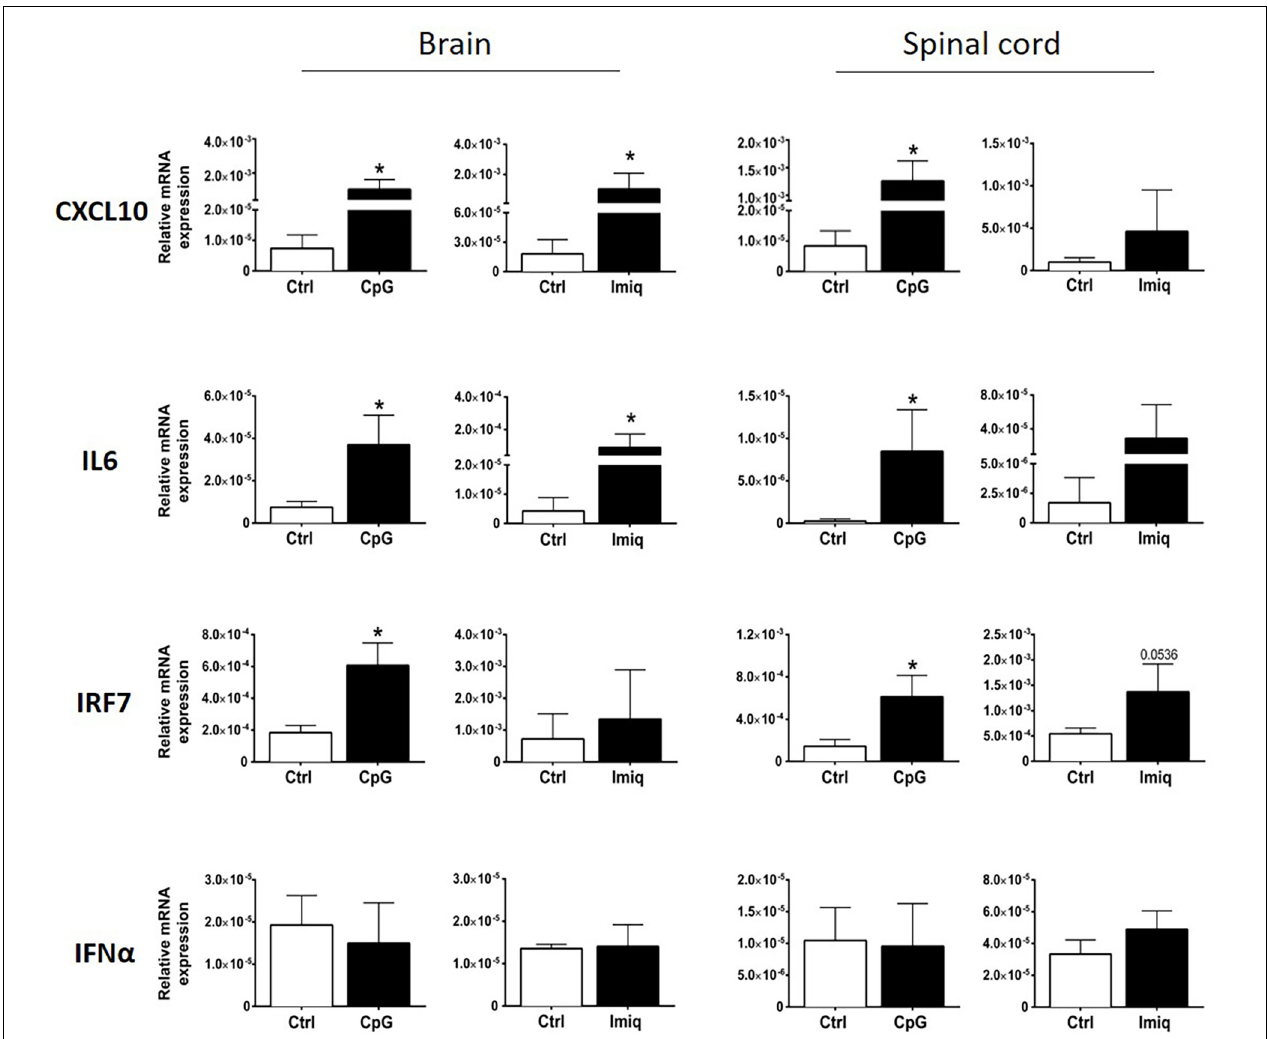
FIGURE 1 | Intrathecal CpG and Imiquimod induced overlapping but distinct immune response in the central nervous system (CNS). mRNA levels of CXCL10, IL6, IRF7, and IFN α ( n = 3–6 per group) in brains and spinal cords were analyzed 4 h post intrathecal injection of CpG and Imiquimod (Imiq) into healthy mice. Results were analyzed using the two-tailed Mann–Whitney U -test. Data are presented as means ± SD. * p < 0.05.